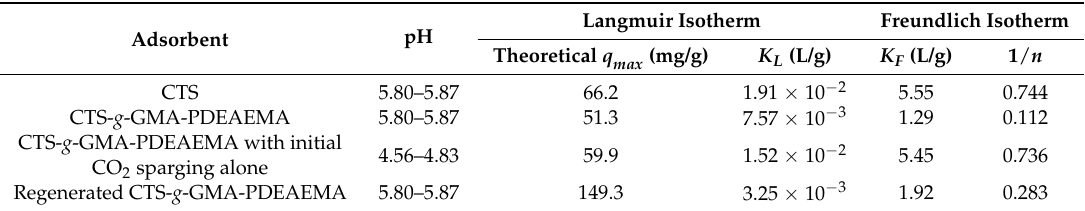
Table 1. Langmuir and Freundlich isotherm (20 °C) parameters derived for the adsorption of Ni(II) onto chitosan and CTS– g –GMA–PDEAEMA for an initial concentration range of 50–1000 mg Ni(II)/L, with SO 42− as the anion.